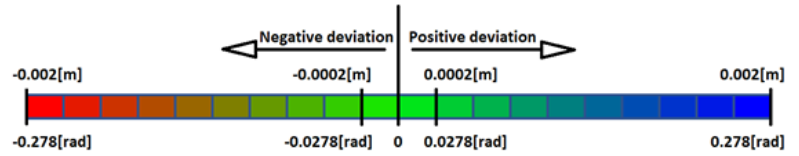
Figure 6. The colour bar represents the range of deviations and the colour to represent it throughout this paper. For angle estimates, the range of deviation is ± 0.278 rad whereas, for the position, the range of deviation is ± 0.002 m.